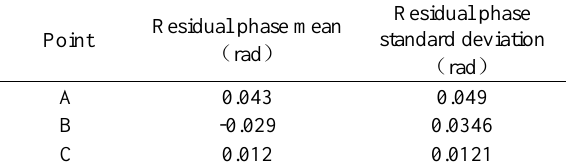
Table 2. Residual phase means and standard deviations of feature